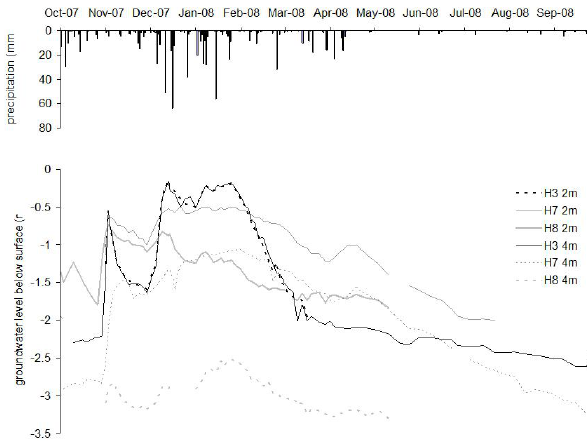
Fig. 8. Hydrometric observations of water table depths within the Manalana wetland October 2007–October 2008 (2m and 4m refer to installed piezometer